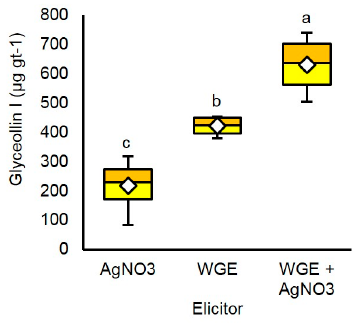
Figure 4. Elicitation with AgNO 3 (5 mM) and WGE (20 mg mL − 1 ) separately and in combination. Two-